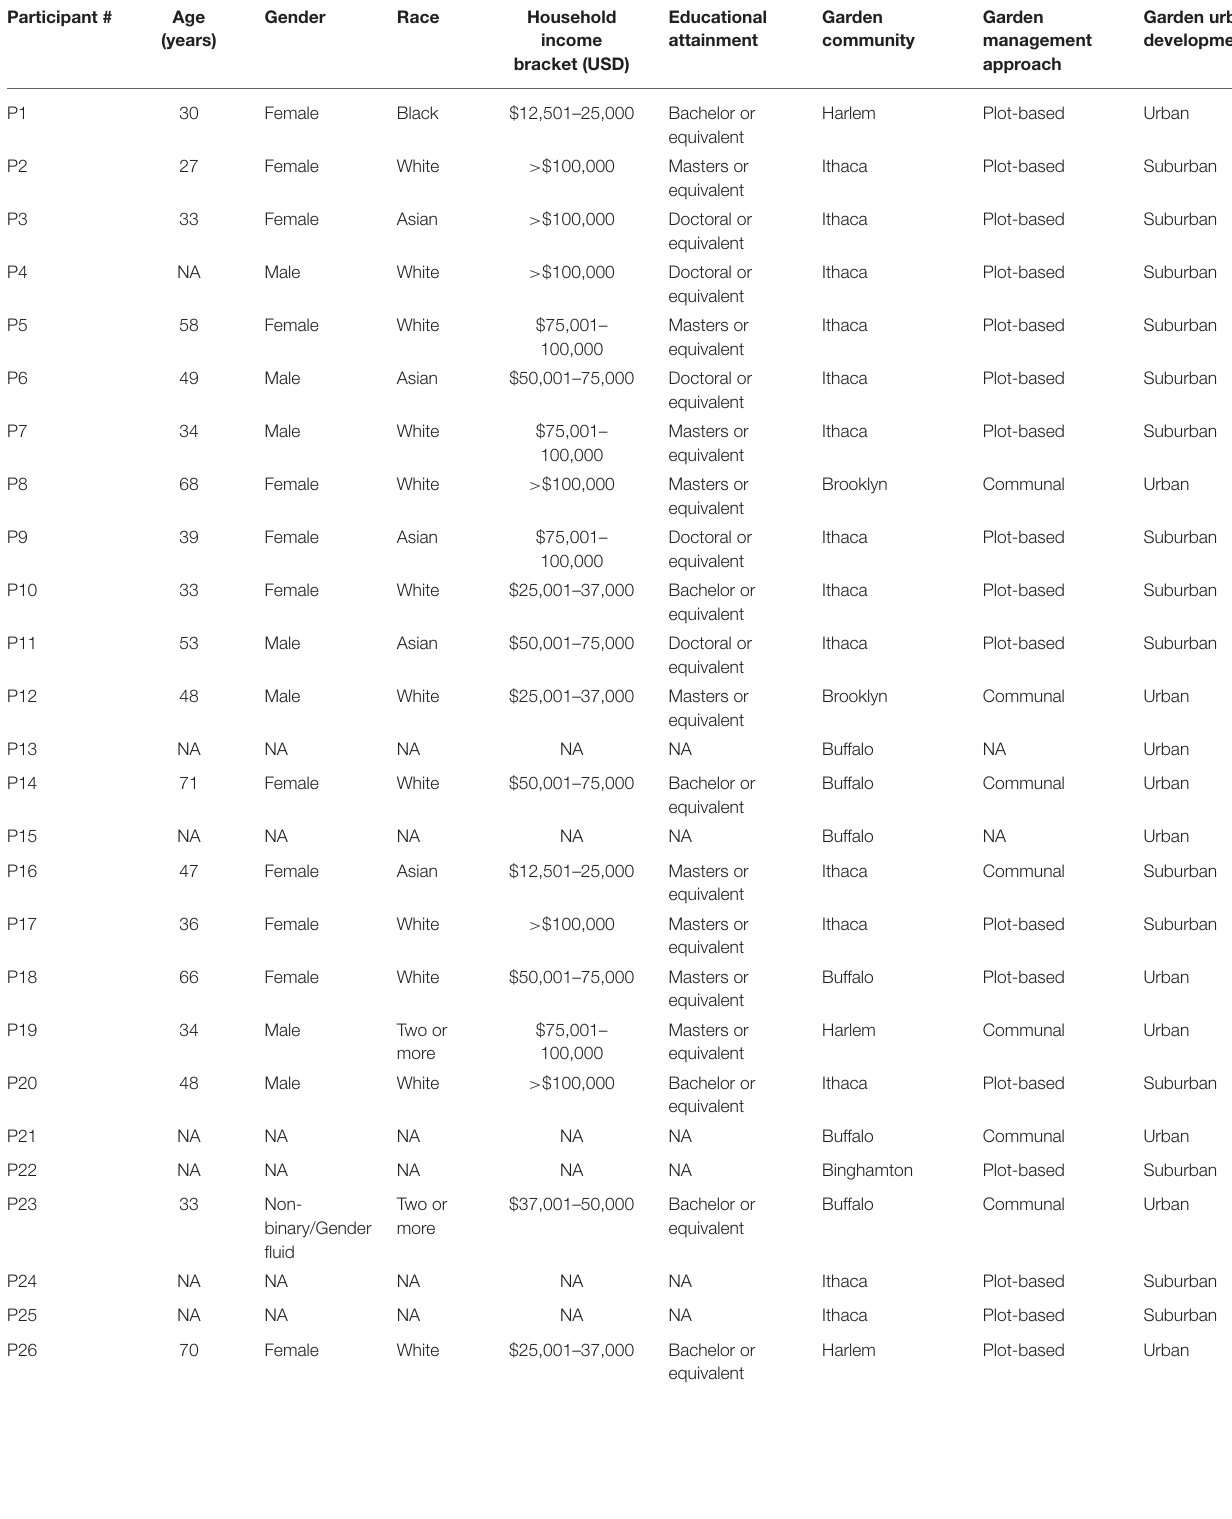
TABLE 2 | Case classifications of interview participants used for quote identification in this manuscript. Participant